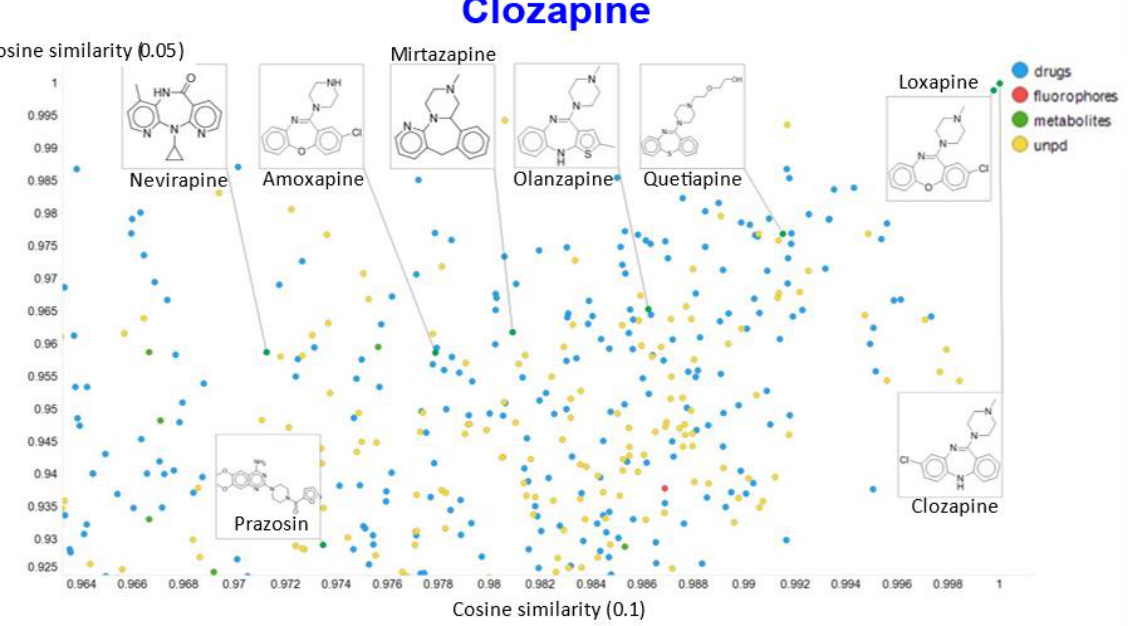
Figure 12. Relationship between cosine similarity for values of the temperature parameter of 0.05 and 0.1 for clozapine in our chemical space.